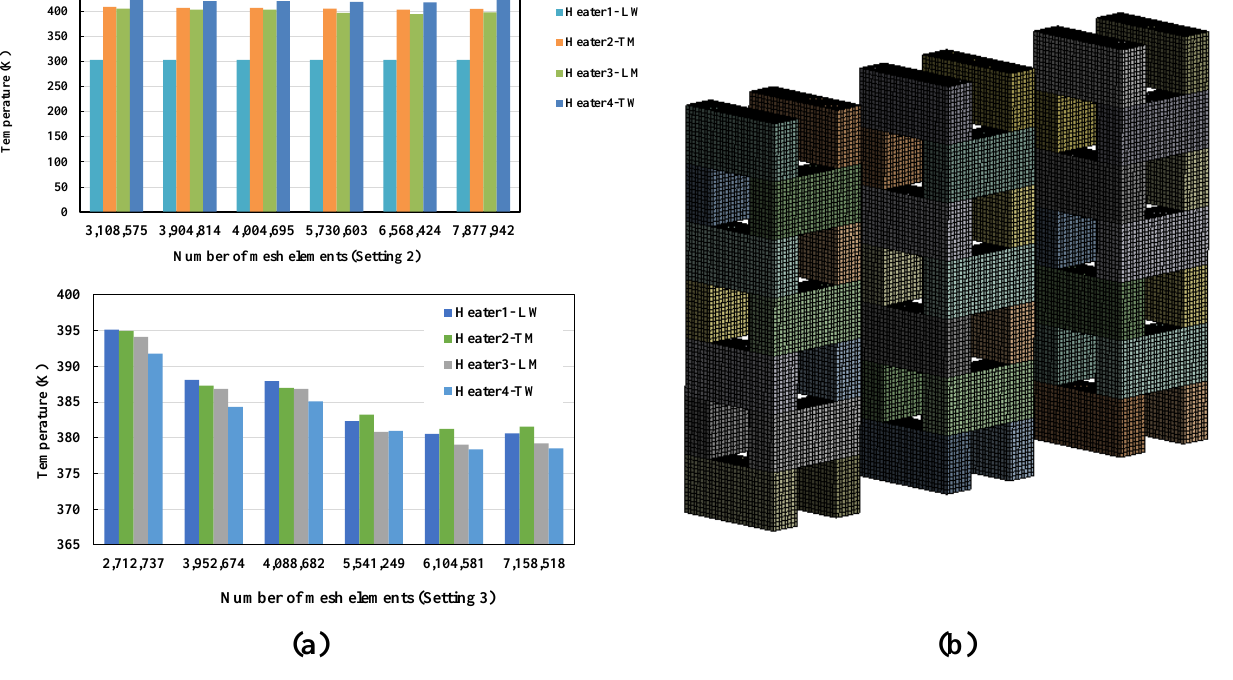
Figure 3. Mesh used in the present study: ( a ) independence study (settings 2 and 3), ( b ) Mesh structure setting 3 [14].